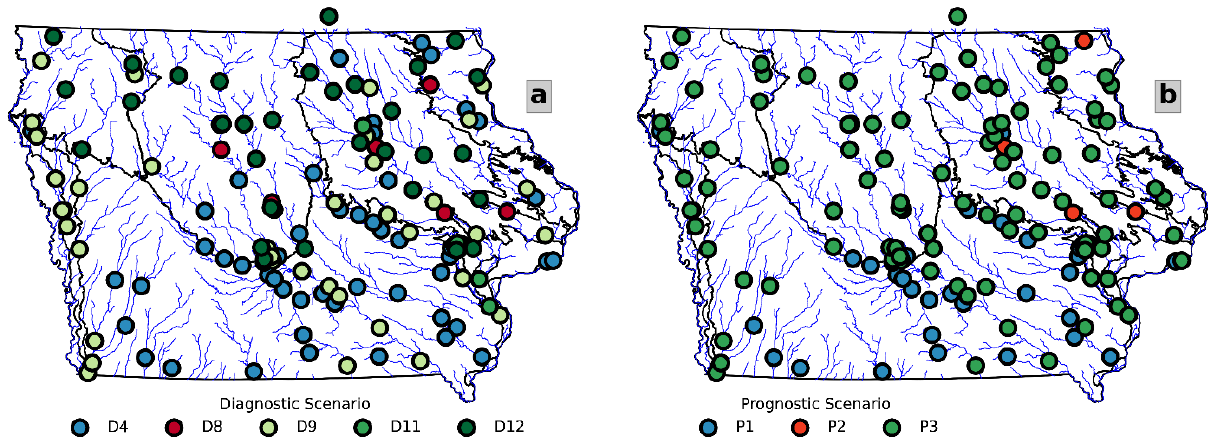
Figure 8. Spatial distribution of the scenarios with best KGE performance at each USGS station: ( a ) results obtained from the diagnostic scenarios; and ( b ) results obtained from the prognostic scenarios. The green, red, and blue gauge colors correspond to the percolation rates of 0.02, 0.03, and 0.04, respectively.